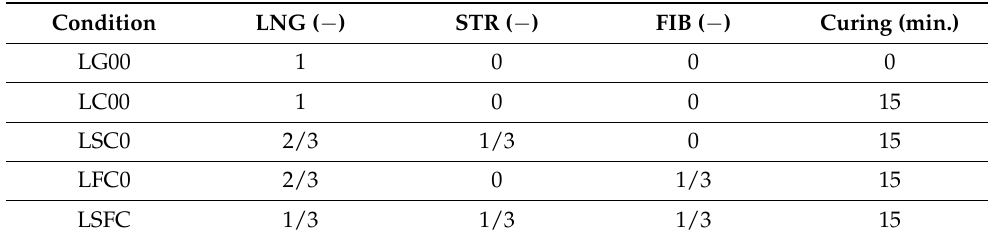
Table 2. Summary of printing conditions of photosensitive composites showing the weight proportion of each phase. LNG: longer photosensitive resin, STR: starch, FIB: natural